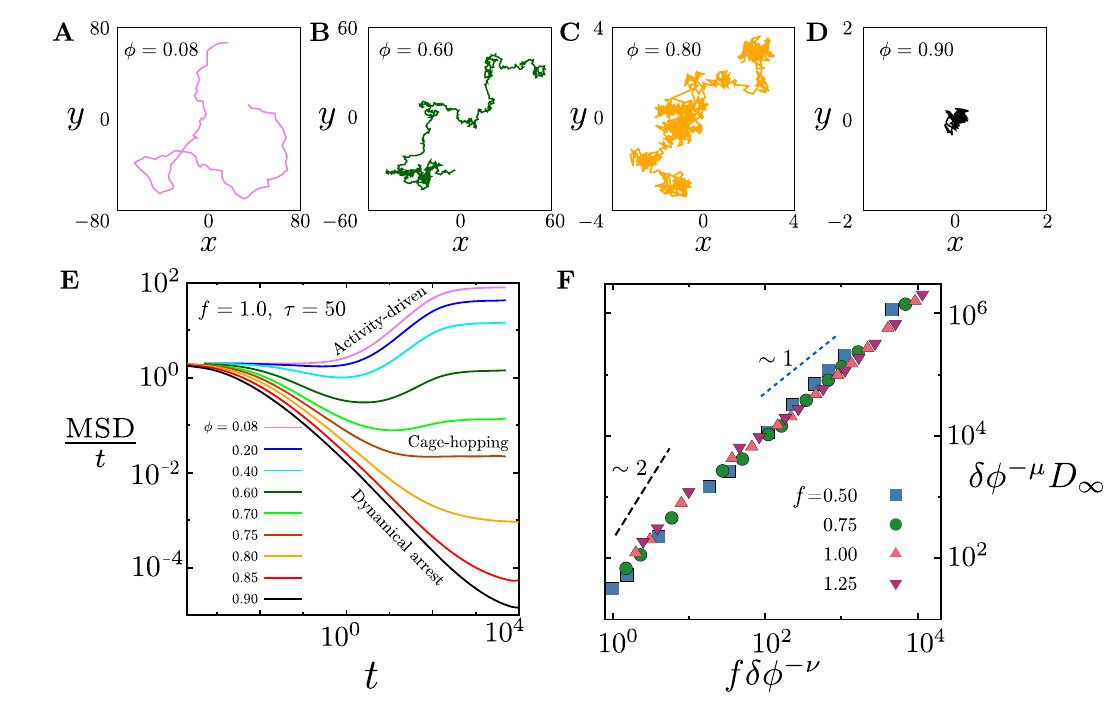
Fig. 2 | Crossover in transport characteristics of minority active particles. A – D Typical trajectories of the active particle as a function of ϕ at fi xed f =1 and τ =50, showing (i)activity-dominatedtransport, (ii)glass dominated cage-hopping transport and (iii) dynamical arrest, recorded over a time t =500. E Mean square displacement (scaled by time) computed from active particle trajectories suggests a crossover as a function of ϕ . These quantities are time averaged (over the time origin) and ensemble averaged (over 64 independent simulations). The numerical